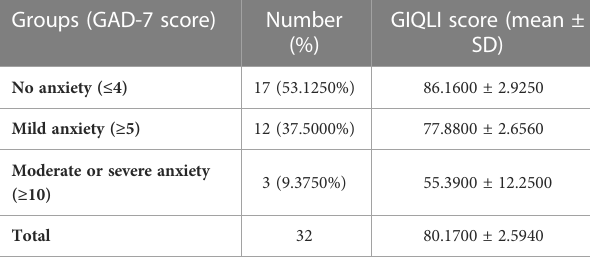
TABLE 2 GAD-7 and GIQLI scores in patients with